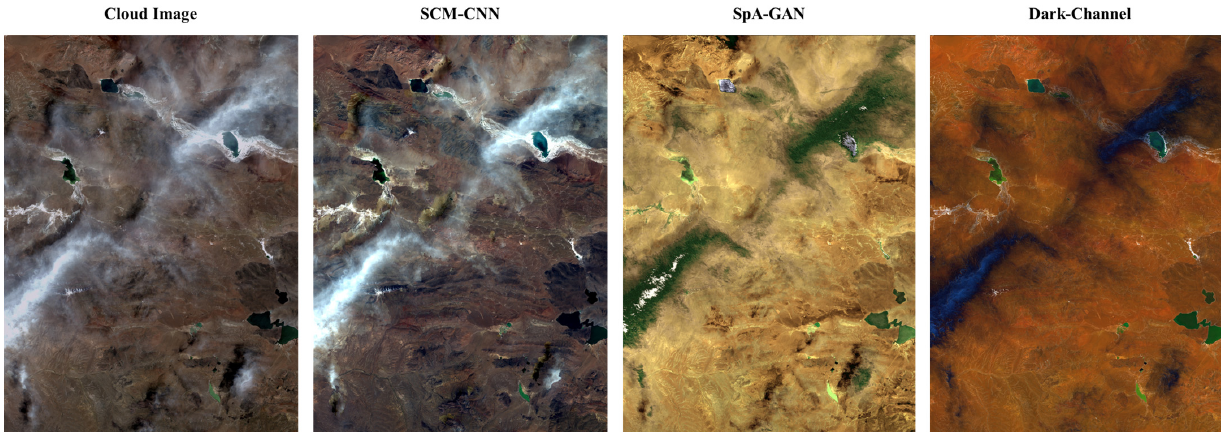
Figure 4. Sentinel-2B observation image and its cloud removal results from orbit 119 on June 29, 2020. This image contains thick and thin clouds and complex information such as snow, mountains, and cloud shadows, which could be used to test each model’s accuracy and reliability effectively. Among them, the predicted images from SpA-GAN and Dark Channel are too dark, thus “normalized pixel stretching” is used for comparison. The original image refers to the attached illustration A2. Table 1. The score of psnr. We utilized the WHUS2-CR dataset to validate the accuracy of our model on actual remote sensing images [29]. Specifically, we selected a subset of 10 high-quality image pairs with and without clouds for comparative analysis.